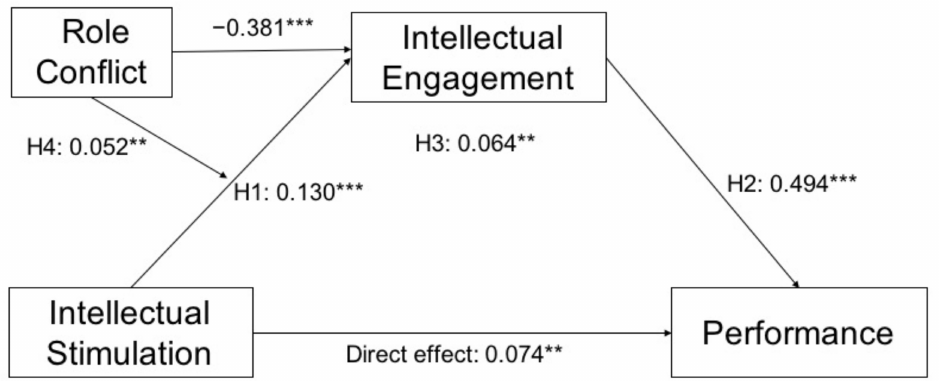
Figure 2. Data research model. Note: *** p > 0.001; ** p >